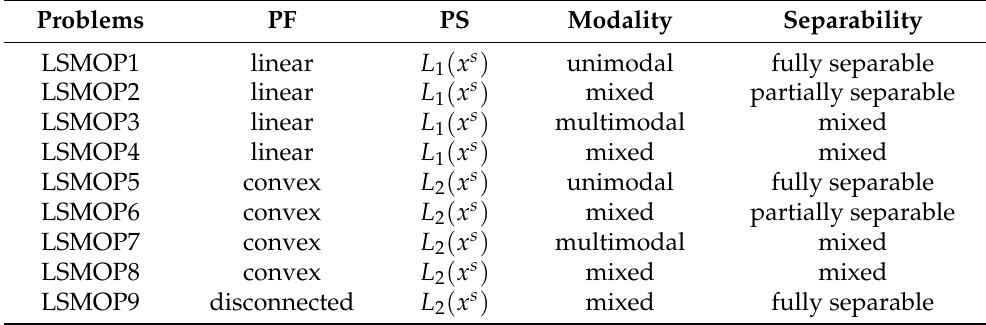
Table 1. The properties and characteristics of